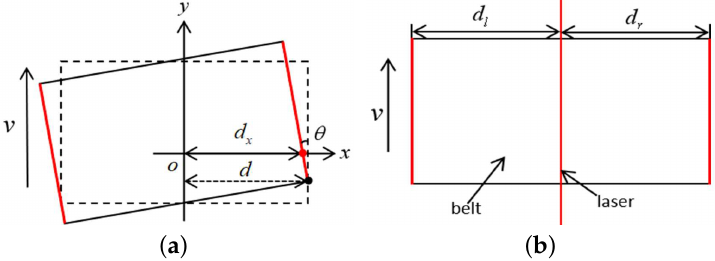
Figure 3. Principle of deviation detection: ( a ) principle of Method 1, ( b ) principle of Method